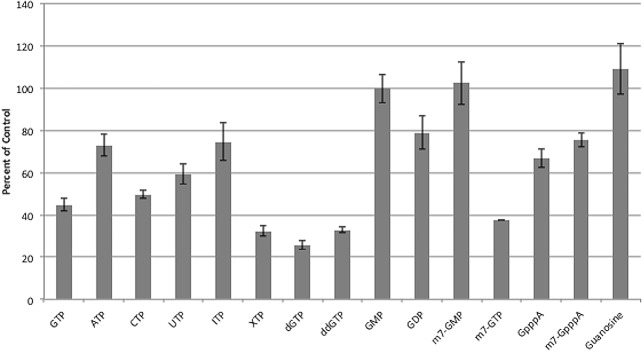
Inhibition of guanylation by GTP analogs.nsP1 was incubated with GTP-680 and 100 μM of each GTP analog for 1 hour. Reactions were resolved on SDS-PAGE gels, scanned for fluorescence on an Odyssey Clx infared imager, and then stained with Coomassie. Guanylation was quantified and normalized to protein amount using ImageJ and Image Studio software. Percent of control (containing no GTP analog) was calculated for each inhibitor. n = 3.